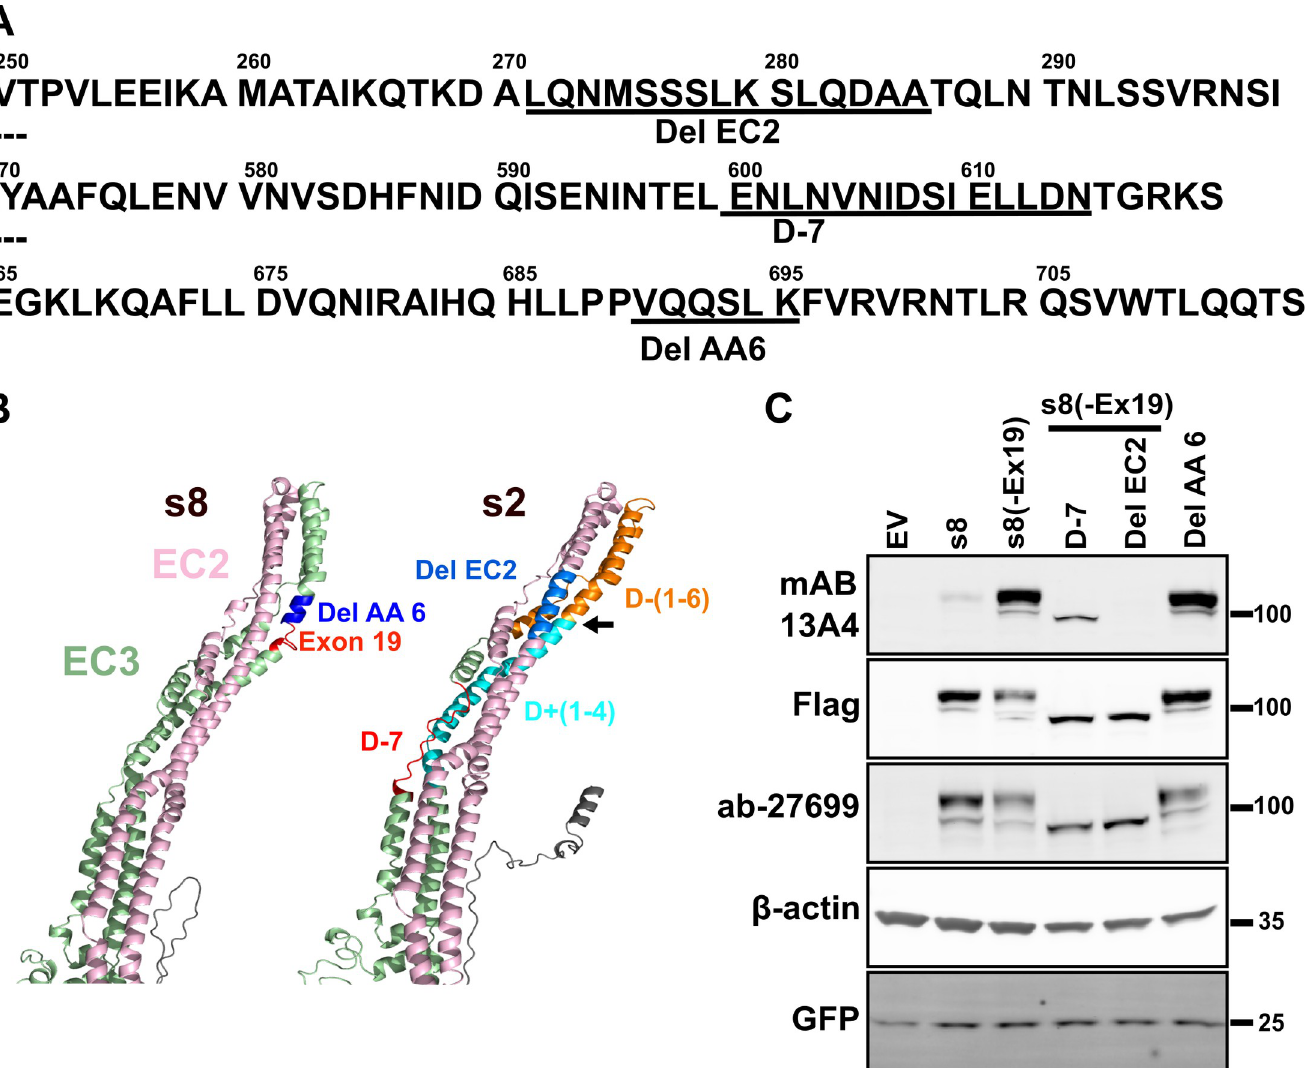
Fig 5. Computationally derived tertiary structure of PROM1 predicts the effect of mutations on the mAB 13A4 epitope. A) Sequence segments from the PROM1 protein with the amino acids deleted in clones Del EC2, D-7 and Del AA6 underlined. B) Partial structure of PROM1 isoforms s8 and s2 showing the positions of the segments deleted in the experiments on Fig 4 and on panel C of this Fig on the tertiary structure of PROM1. Exon 19 is shown in red on the structure of s8. The deletion Del AA6 analyzed on panel C is shown in blue on the structure of s8. On the structure of s2 cyan color indicates deletions D-1 through D-6 and orange indicates deletions D+1 through D+4 from the experiments shown on Fig 4. Also on the structure of s2, the positions of the deletions D-7 and EC2 analyzed on panel C are shown in red and sky blue, respectively. Arrow points to the position of the excluded exon 19 in s2. C) Western blot analysis of PROM1 deletion mutants expressed in N2a cells using mAB 13A4 and Flag-tag antibodies. All transfections were spiked with a vector expressing GFP to control for transfection efficiency.